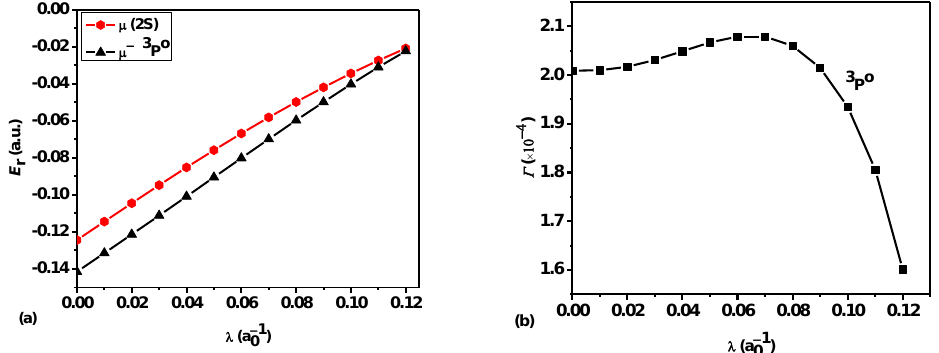
Figure 11. ( a ) Plot of the lowest 3 P o resonance energy 𝐸 𝑟 of Mμ − vs. the screening parameter λ . ( b ) Plot of the corresponding resonance width 𝛤 of Mμ − vs. the screening parameter 𝜆 .